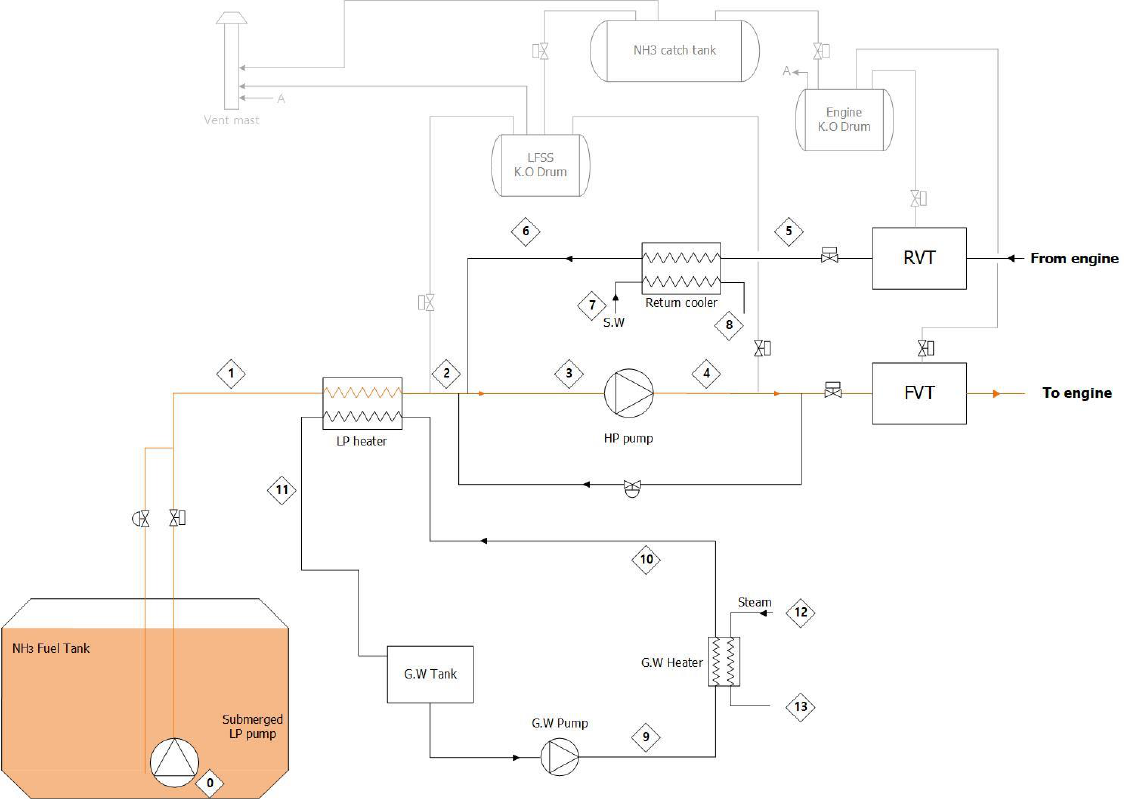
Figure 1. Process flow diagram for NH 3 fuel supply system.